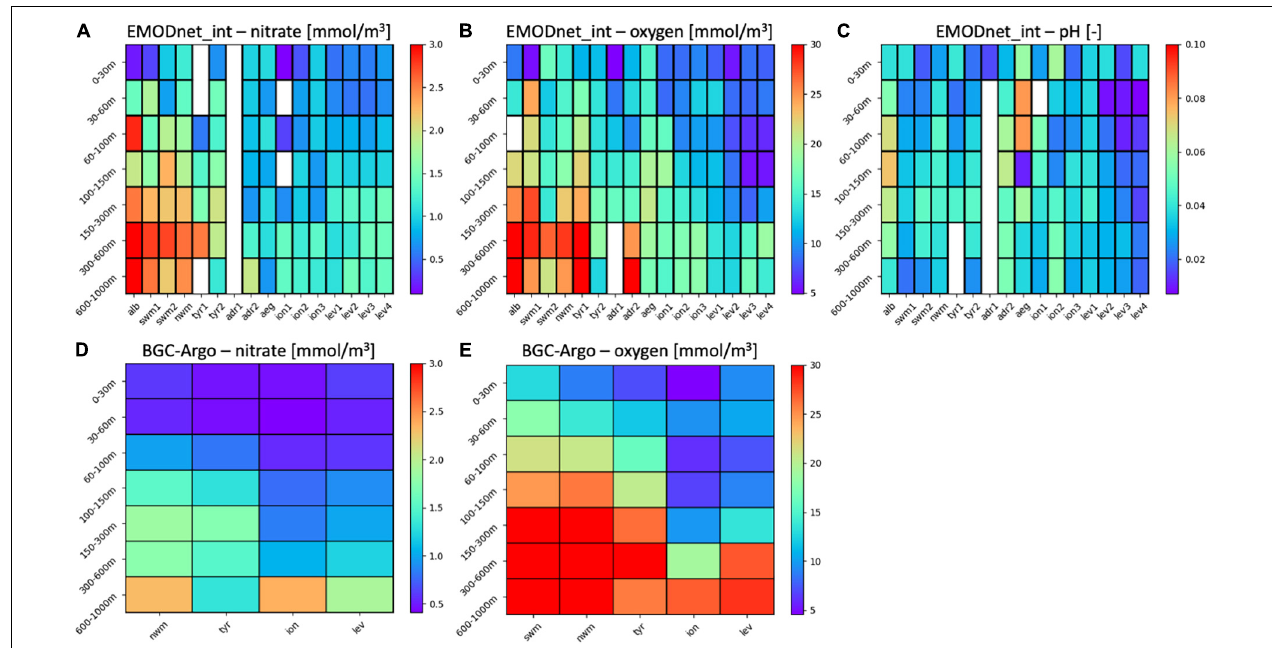
FIGURE 6 | Validation (RMSD metric) for nitrate (A,D) , oxygen (B,E), and pH (C) based on the match-ups between model results and reference data sets EMODnet_int (upper panel) and BGC-Argo (lower panel). White boxes correspond to data unavailability.